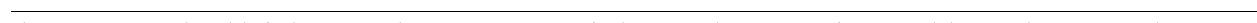
Fig. 6 Computational model of adaptation in the JO. a A sequence of subtractive adaptation, recti fi cation, and divisive adaptation reproduces our experimental data (see also Supplementary Fig. 11a). b – e Signals from different stages of the model in a for step ( b , d 10 ms) and sinusoidal ( c , e 400 Hz) displacement. Adaptation signals and adapted signals are colored red and blue, respectively. Shown are the stimulus (black in b and c ), the linear adaptation signals (red in b and c ), the output of the mean adaptation stage (blue in b and c ), the recti fi ed form of this output (black in d and e ), the recti fi ed adaptation signal (red in d and e ), and the output of the variance adaptation stage corresponding to the overall output of the system (blue in d and e ). f Step tuning curves of the model for different antennal baseline positions (adaptation steps, color coded, see legend) on an absolute scale (left panel) and relative to the baseline (right panel) (compare with data in Supplementary Fig. 10). The model qualitatively reproduces subtractive mean adaptation, which corrects for antennal baseline. g Intensity tuning curves of the model for different noise backgrounds (adaptation intensities, color coded, see legend) on an absolute intensity scale (left panel) and relative to the background intensity (right panel) (compare with data in Fig. 2b, c). Variance adaptation is divisive and compensates for sound intensity. h Intensity tuning of the model for different antennal baseline positions (color coded, see legend in d ) corresponding to different levels of mean adaptation (compare with data in Fig. 5b). Intensity tuning is independent of mean adaptation. i Step responses of the model for different noise backgrounds (color coded, see legend in e ) corresponding to different levels of variance adaptation (compare with data in Fig. 5e). Responses to steps are reduced with variance adaptation. The curves for different background noises or steps in d (right panel), e (right panel), and f are near-identical and hence appear as single